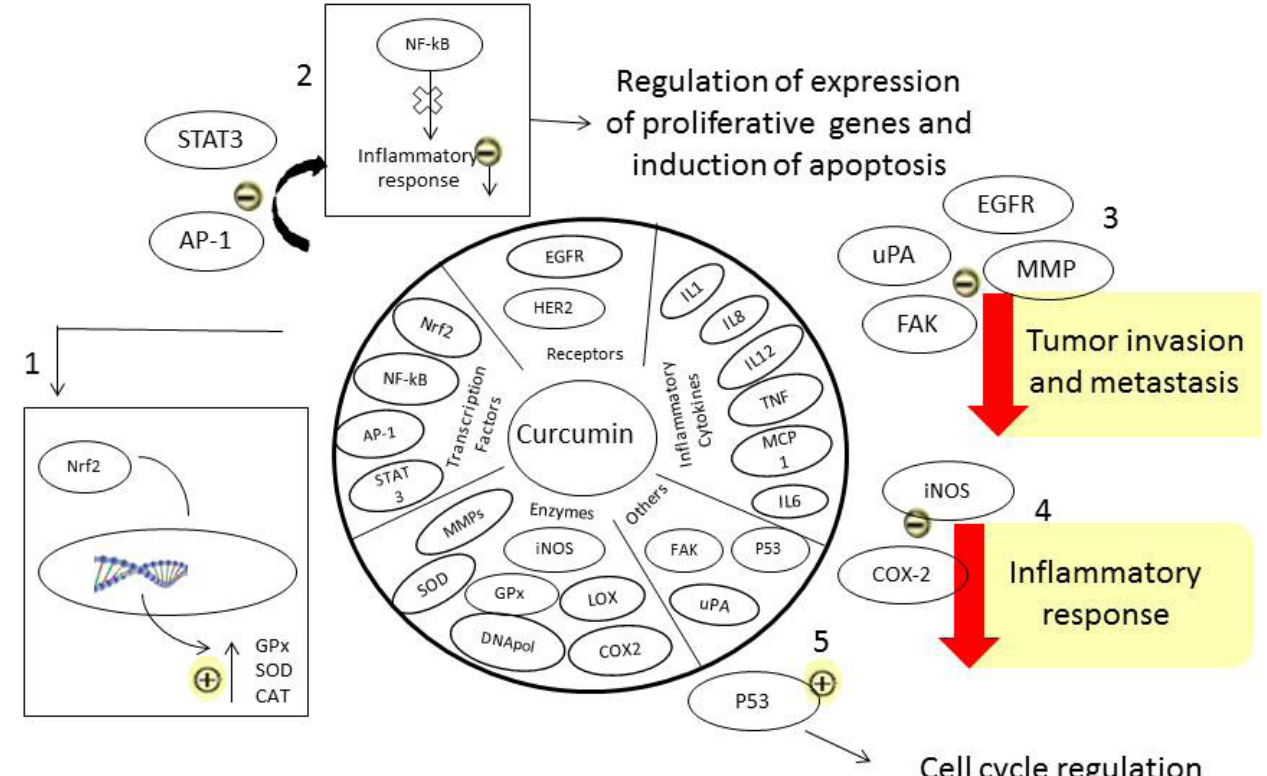
FIGURE 1 – Molecular targets and possible mechanisms of action of curcumin. Adapted from Kunnumakkara et al. (2017) AP-1: Activating Protein-11; COX-2: Cyclooxygenase-2; DNA Deoxyribonucleic Acid; DNA Pol: DNA polymerase; EGF: Epidermal growth factor; FAK: Focal adhesion kinase; GST: Glutathione-S-transferase; HER-2: Human epidermal growth factor receptor 2; IL-1: Interleukin-1; IL-6: Interleukin-6; IL-8: Interleukin-8; IL-12: Interleukin-12; iNOS: Inducible Nitric Oxide Synthase; MCP: Monocyte chemoattractant protein; MMP: matrix metalloproteinase; Nrf2: nuclear factor-erythroid 2– related factor 2; STAT-3: Signal transducer and activator of transcription 3; TNF: Tumor necrosis factor alpha; uPA: Urokinase plasminogen activator. 1 - Curcumin prevents degradation of Nrf2 which leads to an increase in antioxidant enzymes. 2 - Inhibits activation of NF-kB, reducing the inflammatory response, and also inhibits activation of AP-1 and STAT3 by regulating the expression of proliferative genes and inducing apoptosis. 3 - Inhibition of uPA, EGFR, FAK, and MMP leads to air invasion and metastasis of the tumor. 4 - Inhibits iNOS and COX-2, reducing the inflammatory response. 5 - Activates the P53 protein responsible for cell cycle